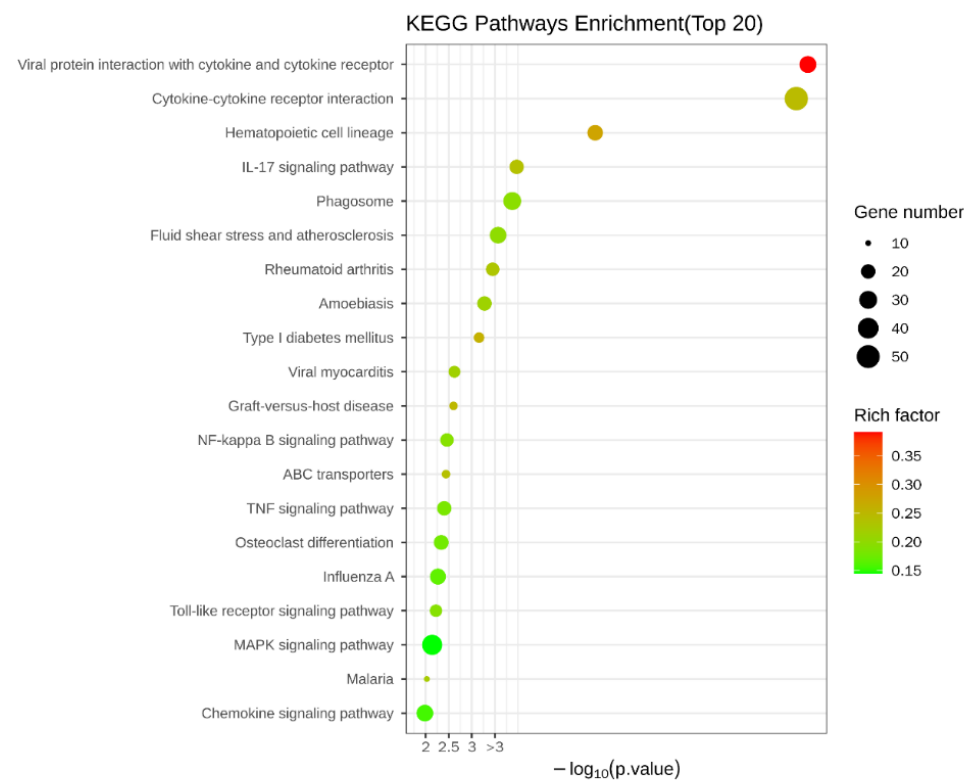
Figure 5. KEGG enrichment of DEGs. The size of the Rich factor is indicated by the color of the dots and the larger the value, the closer the color to red. The number of DEGs in each pathway is indicated by the size of the scatter.